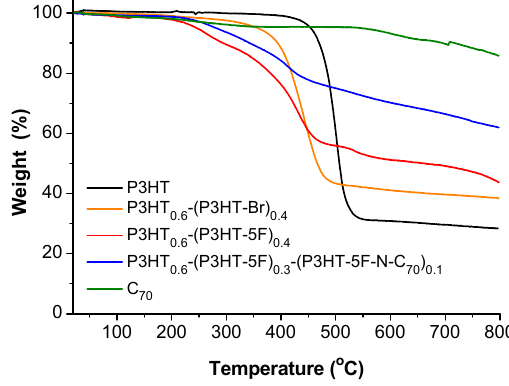
Figure 7. TGA thermograms of rr -P3HT, [P3HT 0.6 -(P3HT-Br) 0.4 ], [P3HT 0.6 -(P3HT-5F) 0.4 ], [P3HT 0.6 -(P3HT-5F) 0.3 -(P3HT-5F-N-C 70 ) 0.1 ] and C 70 fullerene.